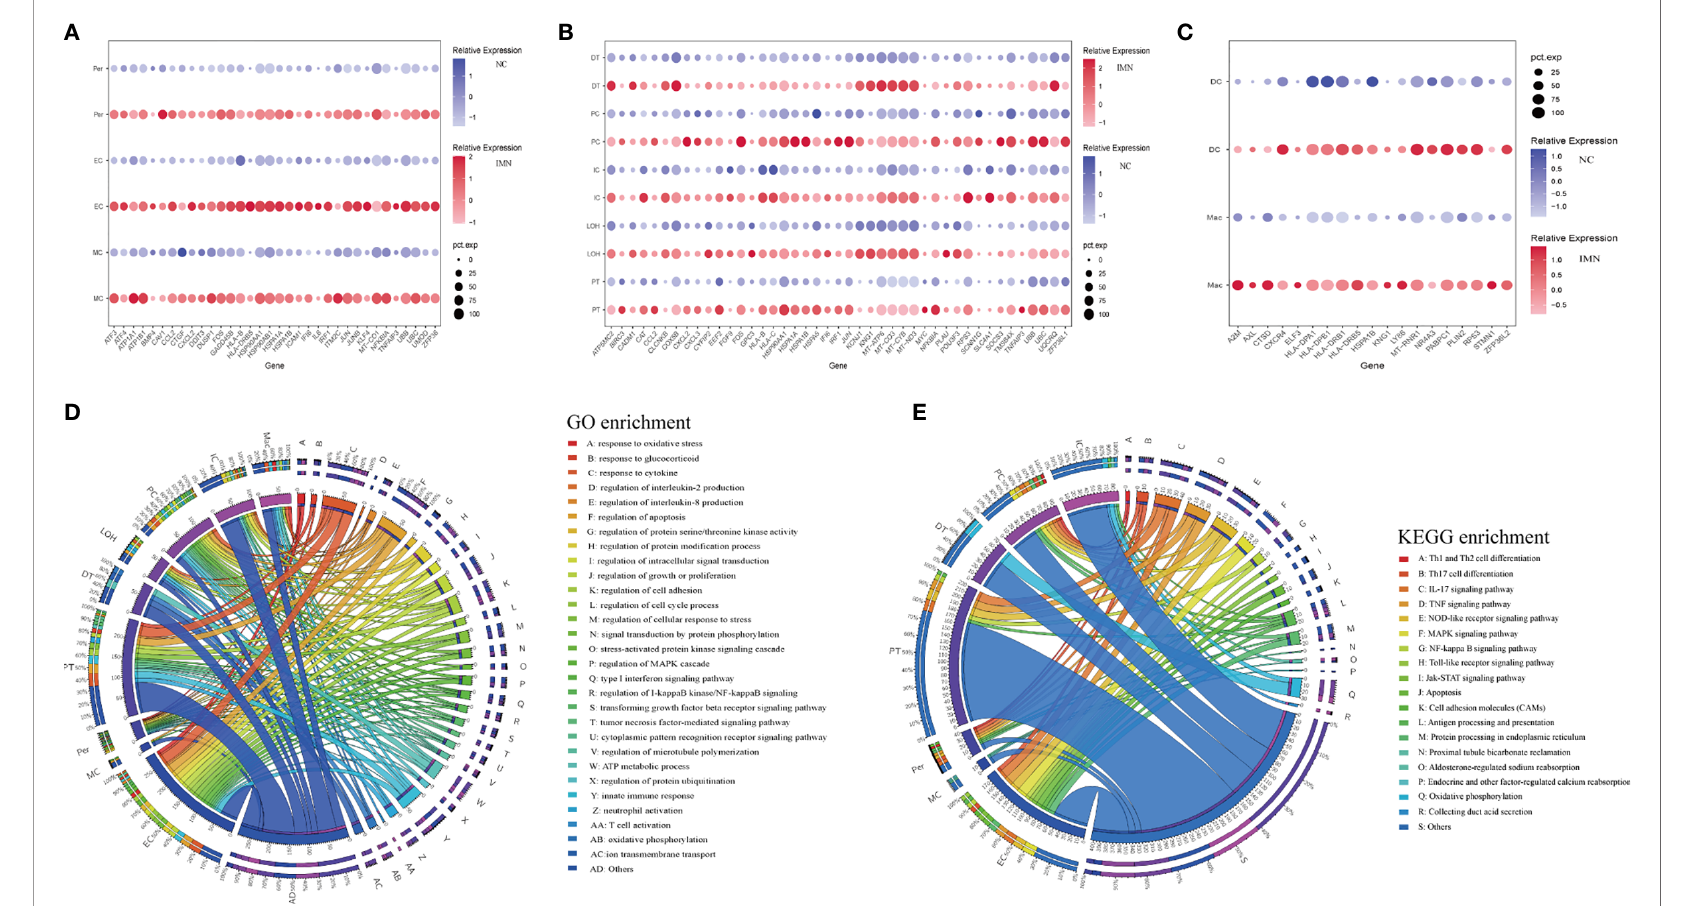
FIGURE 2 | DEGs and enrichment analysis in the kidney cells of anti-PLA2R positive IMN and control subjects. (A) Representative DEGs in mesangial cells, endothelial cells, and pericytes comparing the IMN patients to healthy donor control. pct.exp: percentage of cells expressing gene. (B) Representative DEGs in proximal tubule cells, distal tubule cells, loop of Henle cells, principal cells, and intercalated cells between IMN patients and control. (C) Representative DEGs in immune cells between IMN patients and control. (D, E) GO and KEGG enrichment shows the biological processes or signal pathways involved in different kidney cells, respectively. The left side of the circle represents different cell types, while the right side represents different biological processes or signaling pathways. The inner-circle represents gene numbers involved in cells or biological processes and signaling pathways, whereas the outer-circle represents the proportion of each cell type in biological processes and signaling pathways or the proportion of biological processes and signaling pathways in kidney